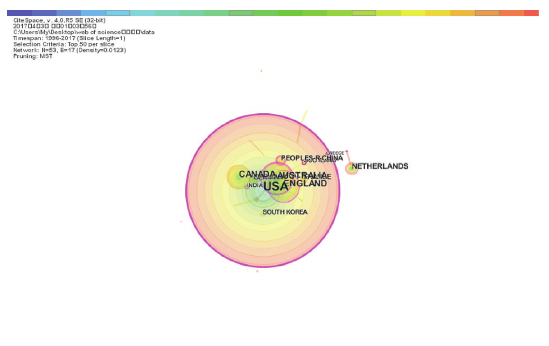
Figure 2. Network of co-countries (regions) publishing research papers on self-management by patients with breast cancer (one-year